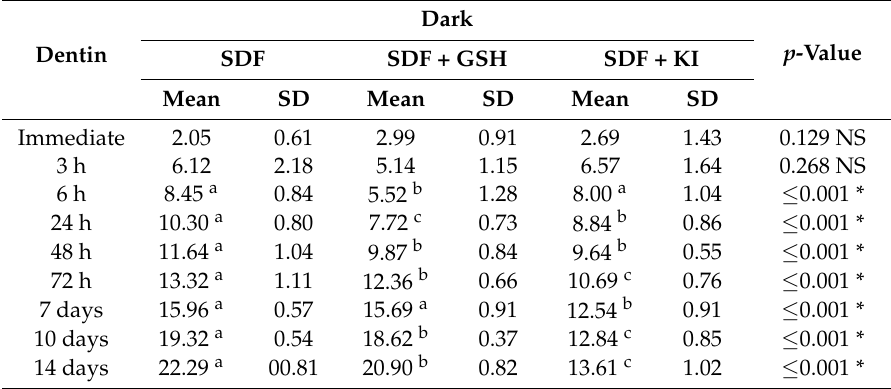
Table 4. Mean and SD for ΔE for different tested groups at all of the time intervals within dentin under dark conditions.